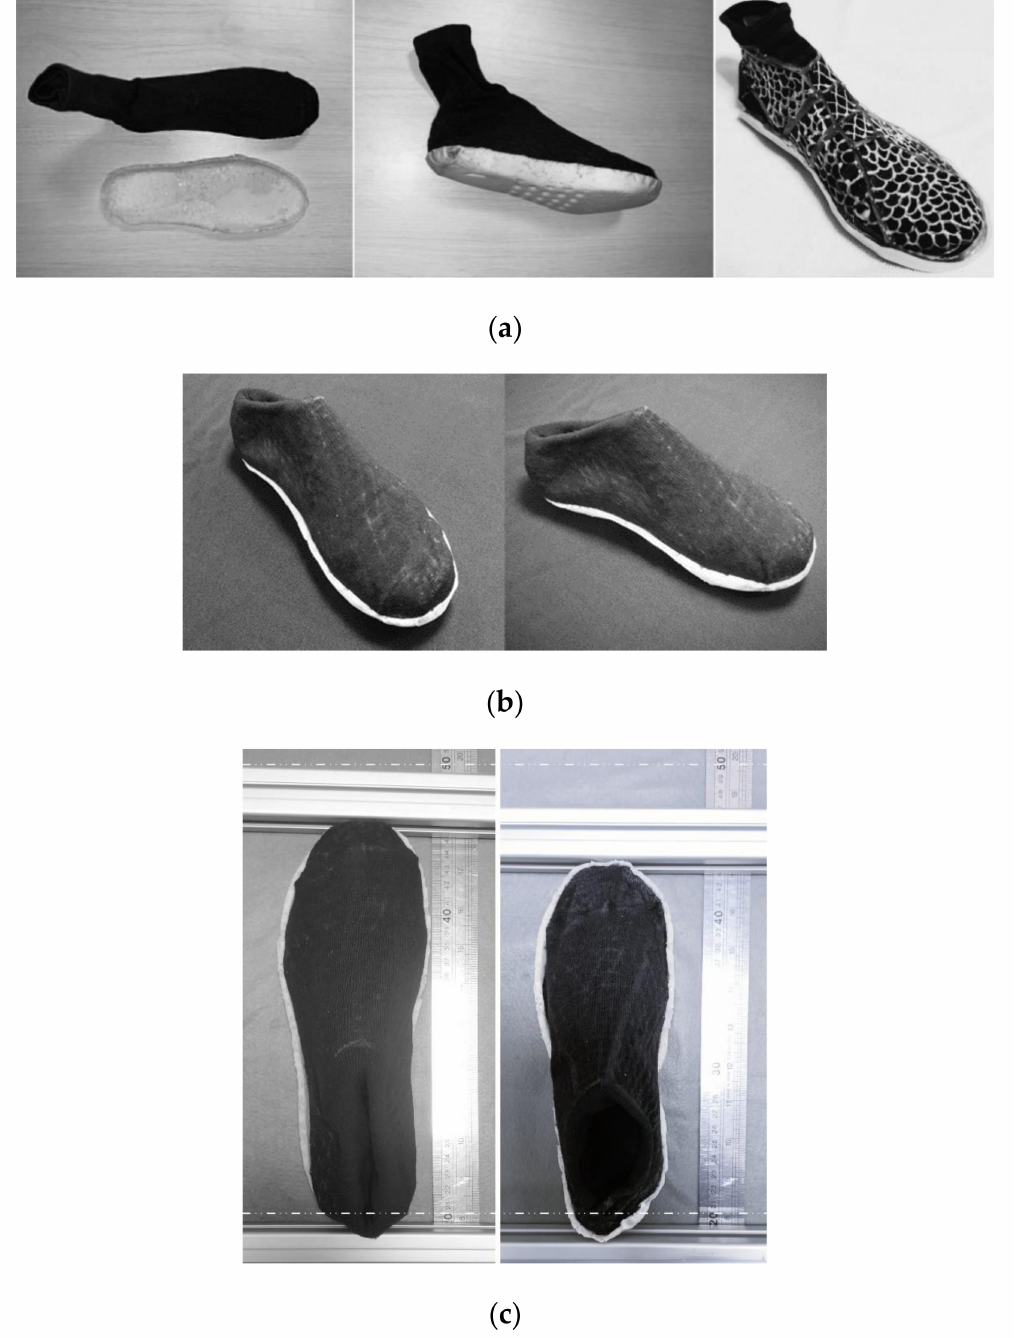
Figure 22. Shape memory sock-shoes. ( a ) Left: before assembly; middle and right: two versions of sock-shoes; ( b ) after fitting of Figure 22a middle image; ( c ) comparison of size (left: after fitting; right: after recovery). Silicone glue (4120, Shenzhen Hong Ye Jie Technology Co Ltd., Shenzhen, China) was used as the bonding agent to bond the shape memory sponge sole to this sock. The